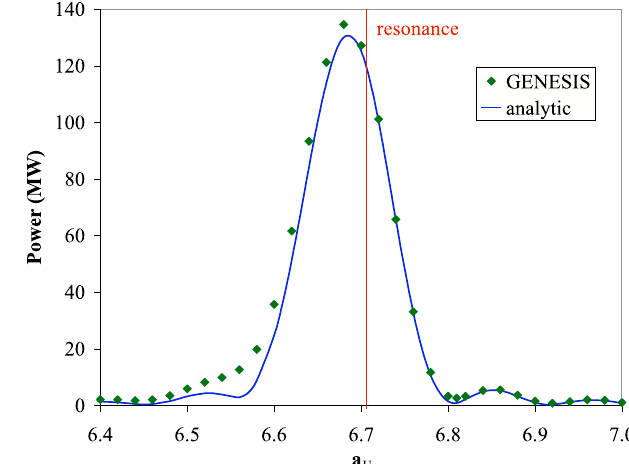
FIG. 3. (Color) Comparison of analytic theory with simulations using GENESIS . Results are shown for harmonic generation at 50 and 1.04 nm, as the energy spread (cid:3)